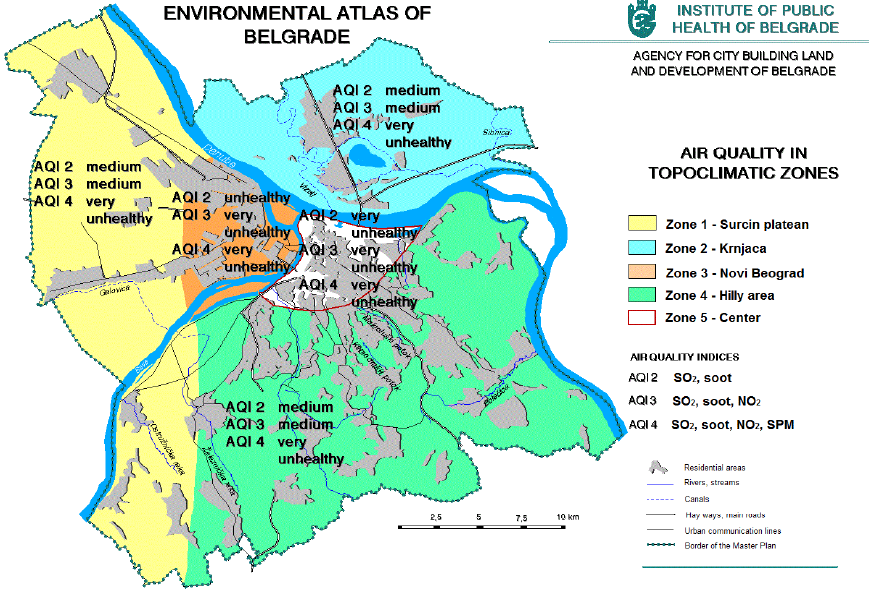
Figure 5. The air quality of Belgrade (https://www.zdravlje.org.rs/ekoatlas/volbe/36ev.gif, accessed on 23 August 2022).